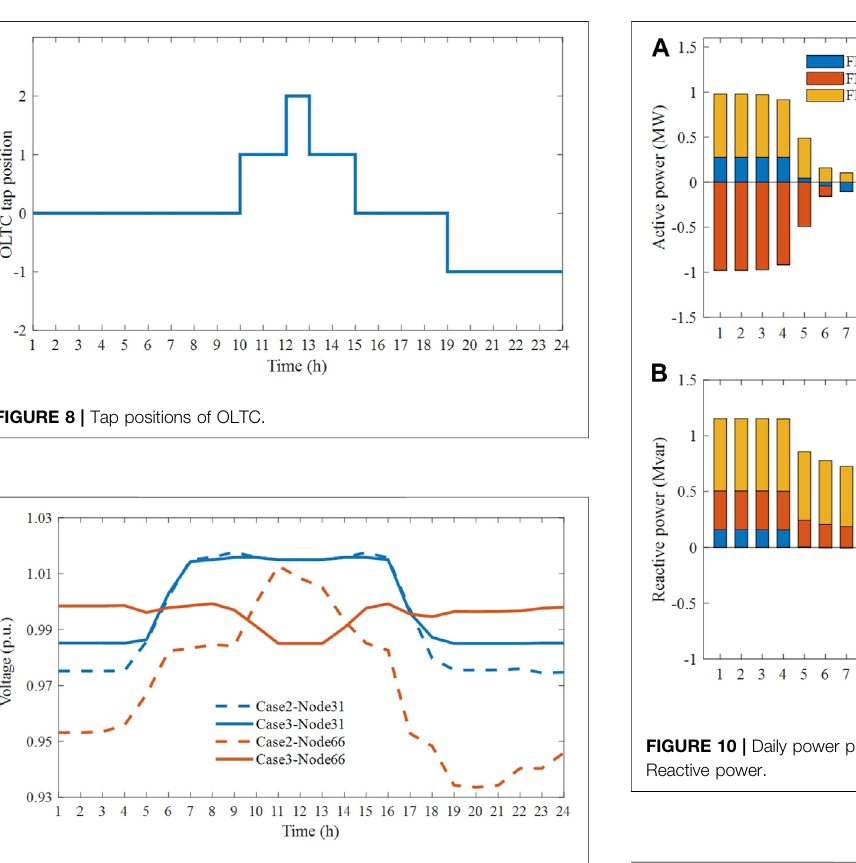
FIGURE 9 | Voltage pro fi les at Node 31 and Node 66 in Case 2 and Case 3.